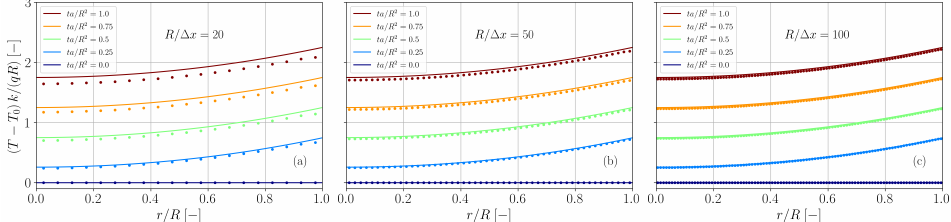
Figure 23. Comparison of simulation results (dots) and analytical solution (solid lines, Equation (69)) for the temperature distribution in a rod with surface heat flux. The spatial resolution is varied between R / ∆ x = 20 ( a ), R / ∆ x = 50 ( b ) and R / ∆ x = 100 ( c ).